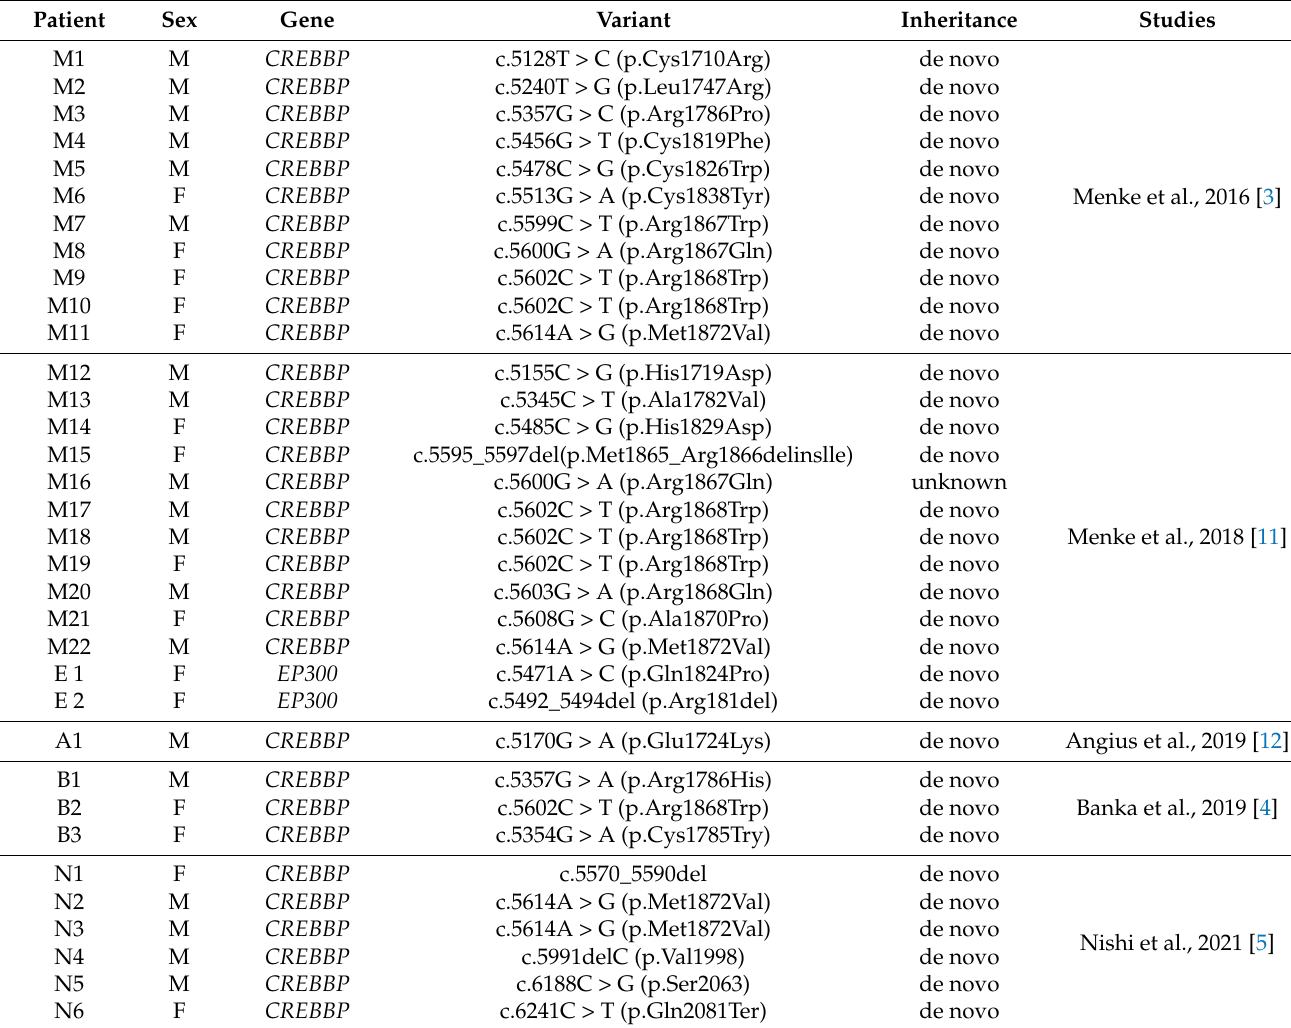
Table 1. The genotype of individuals reported with CREBBP / EP300